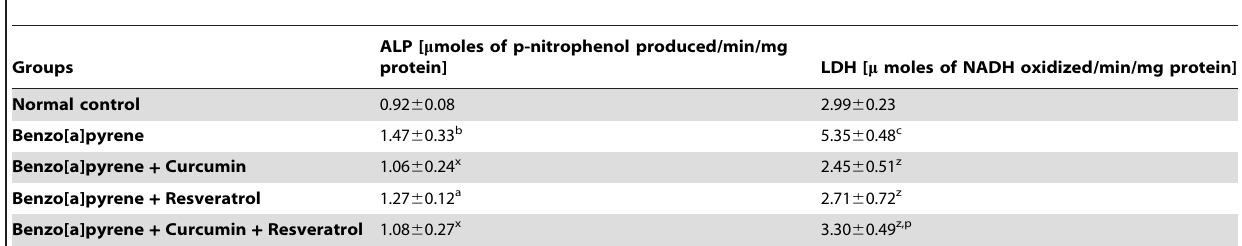
Table 5. Effect of 22 weeks of curcumin and resveratrol treatments on the activity of alkaline phosphatase [ALP], lactate dehydrogenase[LDH] in serum of mice subjected to benzo[a]pyrene treatment.